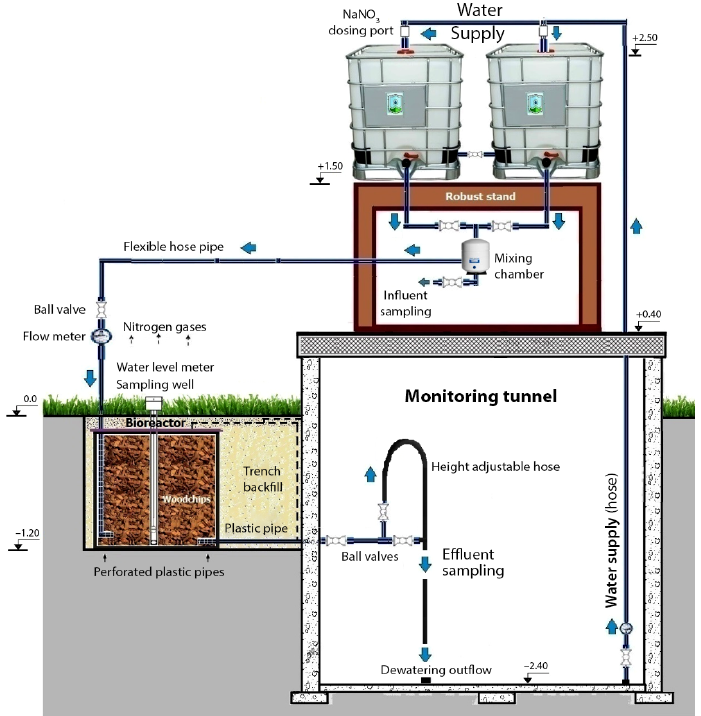
Figure 1. Schematic of the pilot-scale woodchip